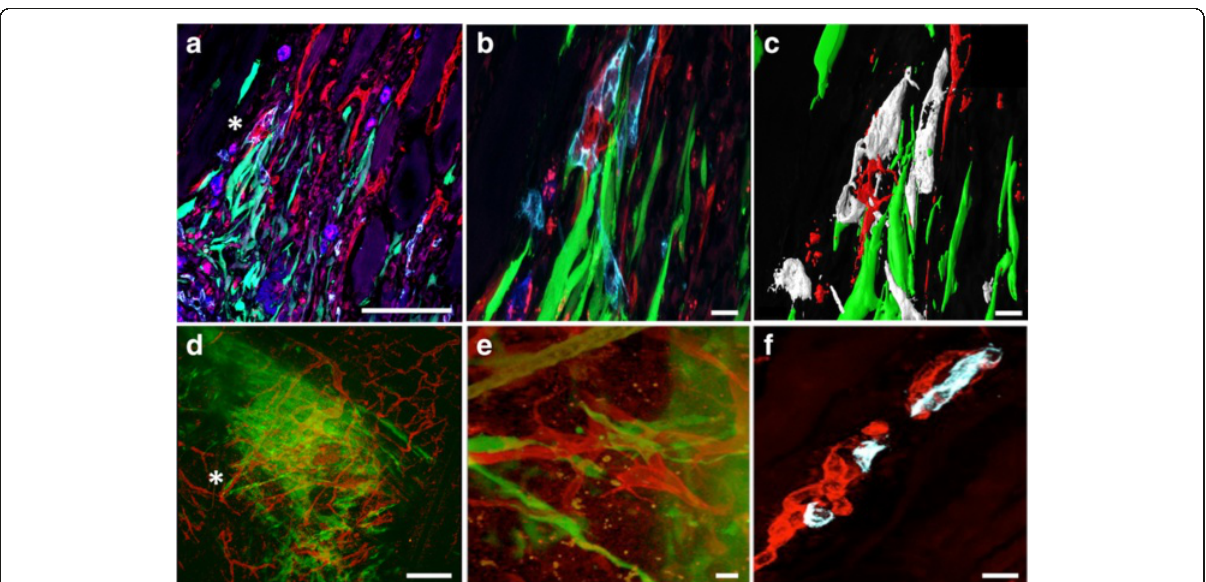
Fig. 7 Cellular interactions between MSC and human islet endothelial cells with the recipient vasculature one week post transplantation. a Interactions between MSC (green) and the CD31 expressing human islet endothelial cells (light blue) with the recipient vasculature (red). b Increased magnification in asterisk marked area of panel A showing the interactions between the MSC and human islet endothelial cells where the MSC are wrapped around the mouse vasculature. c Imaris visualization of the image shown in panel b. d In situ staining and in situ confocal microscopy created an overview of the graft area showing sprouting MSC (green) close to the mouse vasculature (red). e Increased magnification of the asterisk area in panel d showed MSC in green wrapped around the mouse vasculature in red. f Formation of a chimeric blood vessel in the close proximity of the MSC. The human islet endothelial cells (white) are fused with the murine blood vessel (red). Bars=100 um in panel a and d, 5 um in panel b and c and 10 um in panel e and of the animals (Additional file 2: Figure S2) may indicate